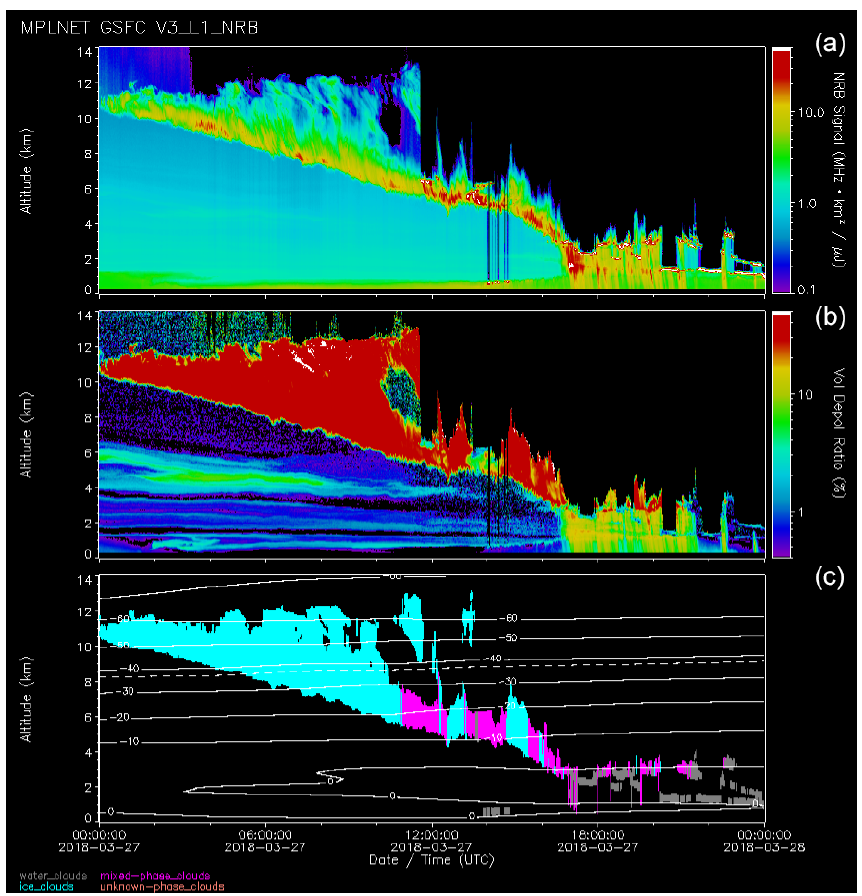
Figure 6. Frontal cloud system at GSFC on 27 March 2018: NRB (a) , volume depolarization ratio (b) and phase mask (c) . Altitude bins where the signal uncertainty is twice the signal strength have been suppressed for easier viewing. Note the use of a log scale for the NRB. The phase mask indicates liquid water clouds (grey), mixed-phase clouds (magenta), ice clouds (cyan), and unknown phase (pink). The GEOS-5 temperature is shown by the contour lines (in 10 ◦ C intervals). The − 37 ◦ C isotherm is indicated by the dashed contour